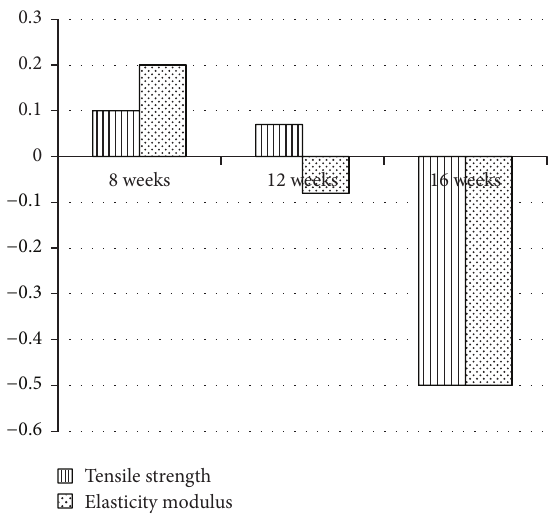
Figure5:Correlationcoefficientbetweenlamenessandbiomechan- ical properties. Elevated inverse correlation between lameness and tensile strength and elasticity modulus at 16 weeks of